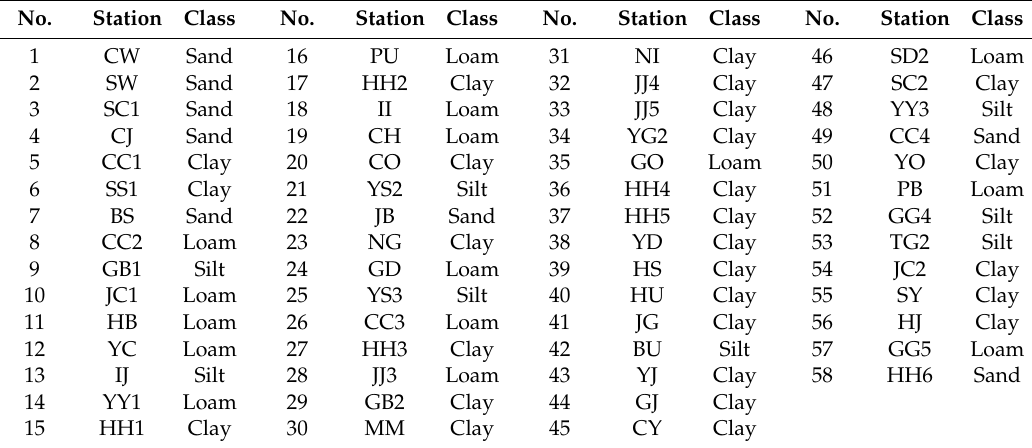
Table 1. Soil moisture stations with soil